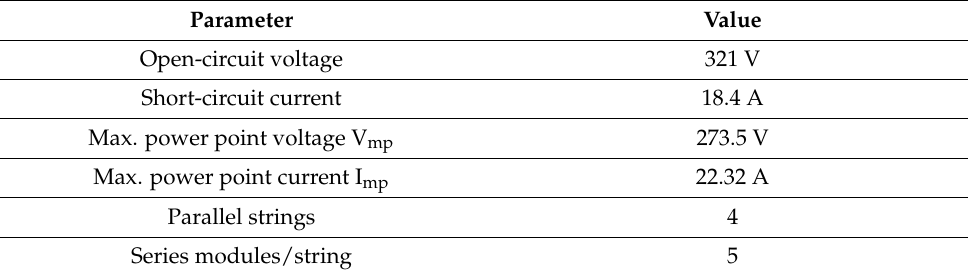
Table 3. The PV system